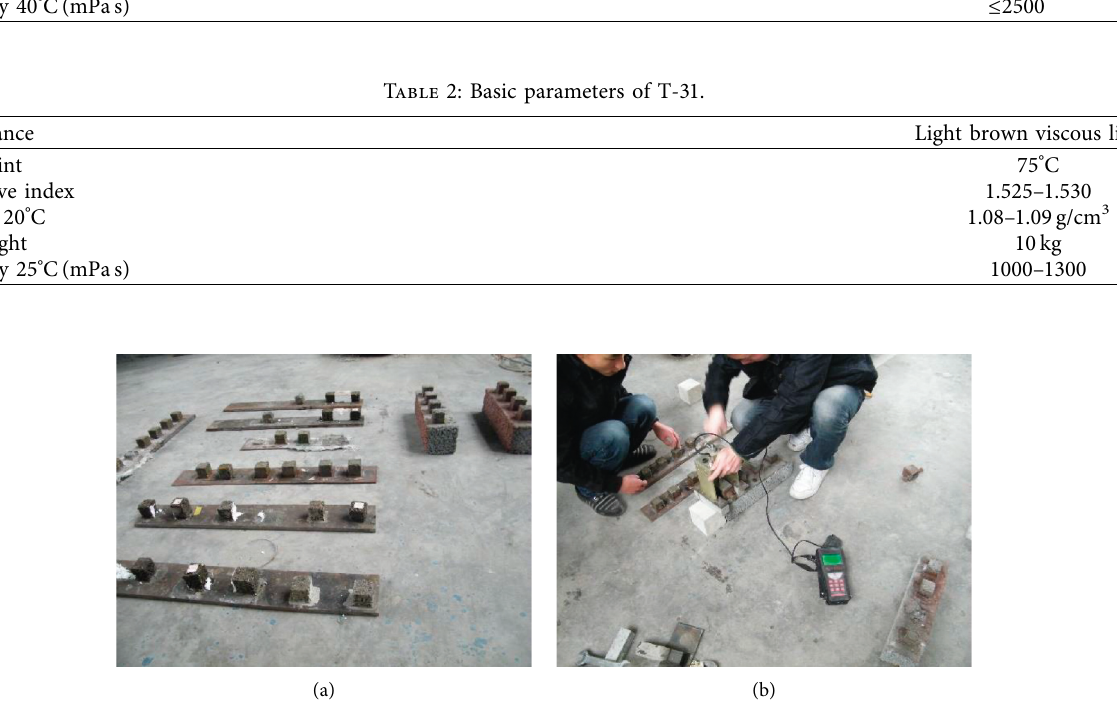
Figure 2: Pull-off test of interfacial bonding. (a) Test piece. (b) Test